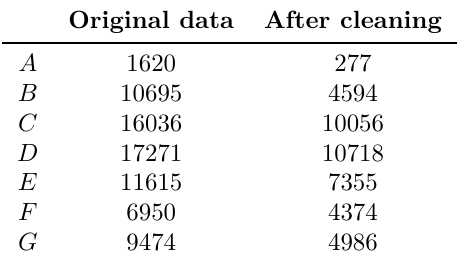
Table 2. Number of certificates per label before and after cleaning the